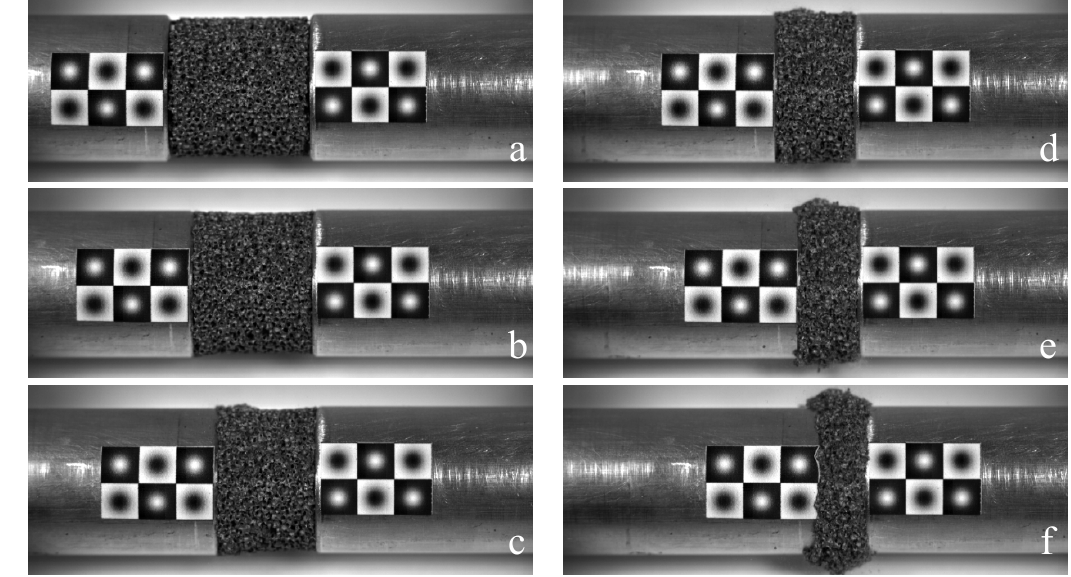
Figure 11. High ‐ speed photo sequence of a MHPB ‐ SM test: ( a ) 0.36 ms; ( b ) 1.00 ms; ( c ) 1.64 ms; Figure 11. High-speed photo sequence of a MHPB-SM test: ( a ) 0.36 ms; ( b ) 1.00 ms; ( c ) 1.64 ms; ( d ) 2.28 ms; ( e ) 2.92 ms; ( f ) 3.56 ms. ( d ) 2.28 ms; ( e ) 2.92 ms; ( f ) 3.56